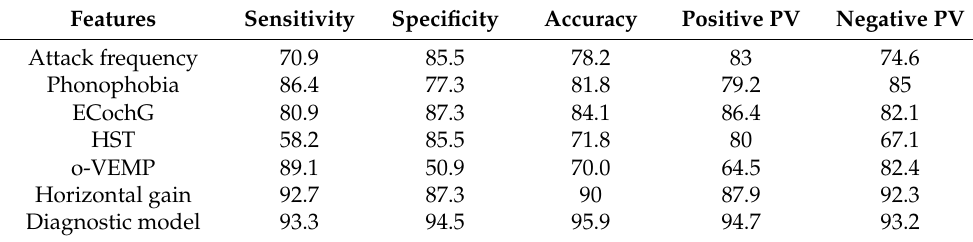
Table 4. Sensitivity, specificity, accuracy, positive PV, and negative PV tabulated for significant